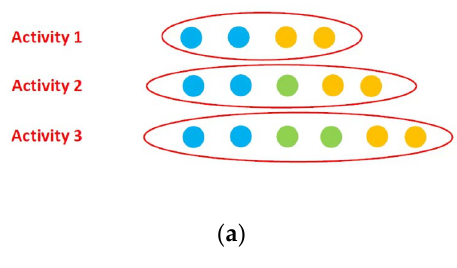
Figure 5. Concept of the differences in activities between activity and routine discovery methods ( a ) without virtual location and routine and ( b ) with virtual location and routine.